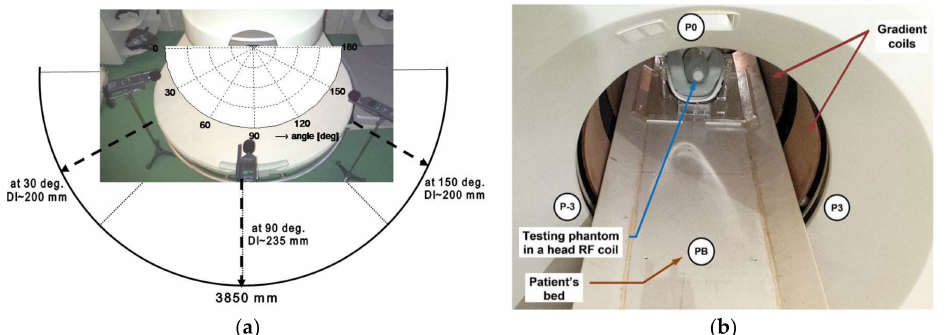
Figure 2. Arrangement of the noise and vibration measurements: in the open-air magnetic resonance imaging (MRI) device Opera together with principal angle diagram of the MRI scanning area; ( a ) sound pressure level (SPL) meter situated at 30 ◦ , 90 ◦ , and 150 ◦ ; ( b ) in the whole-body imager TMR-96.